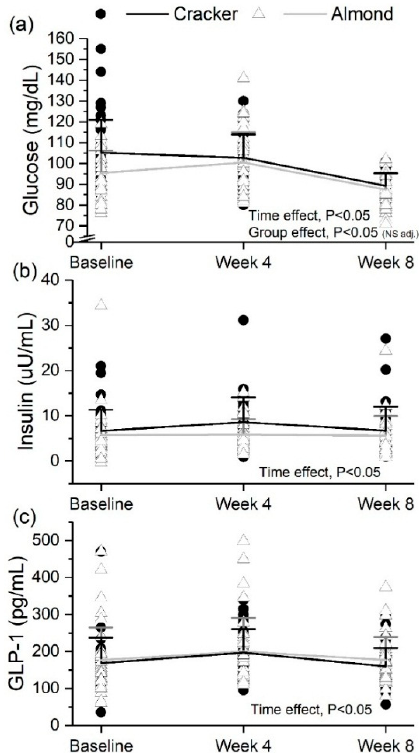
Figure 3. Fasting serum ( a ) glucose, ( b ) insulin and ( c ) GLP-1 profiles of the cracker and almond groups at baseline, week 4 and week 8 of the intervention. Values are individual data points representing each participant at baseline, week 4 and week 8. Means ± SDs of the 2 snack groups at baseline, week 4 and week 8 are also plotted. Analysis was conducted using a linear mixed effects model with week as within-subject factor and snack group as between-subject factor. Insulin and GLP-1 values were transformed prior to analysis using Johnson’s family of transformations. Cracker: n = 35, Almond: n = 38. Glucose time effect: baseline vs. week 8, p < 0.05; week 4 vs. week 8, p < 0.05. Insulin time effect: baseline vs. week 4, p < 0.05; week 4 vs. week 8, p < 0.05. GLP-1 time effect: baseline vs. week 4, p < 0.05; week 4 vs. week 8, p < 0.05. NS adj.: non-significant after baseline adjustment.